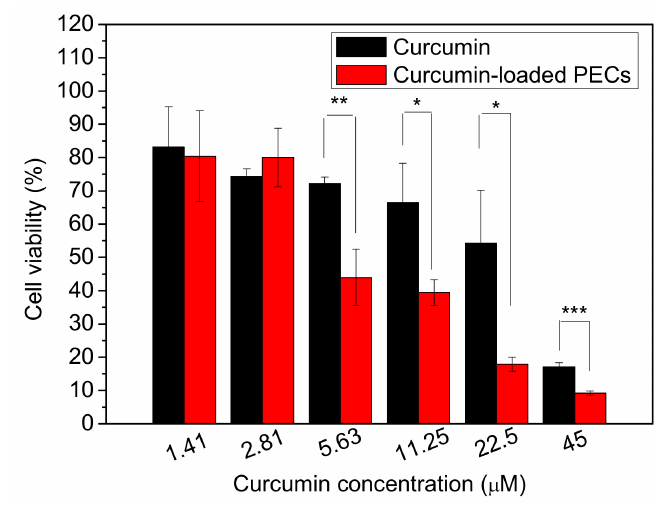
Figure 7. Cell viability. Curcumin and curcumin-loaded PECs were pretreated with pH 2.0 for 2 h and pH 8.0 for 4 h. Afterward, the pH values were adjusted back to 7.4. Next, HCT116 human colon cancer cells were incubated with the curcumin and curcumin-loaded PECs at 37 ◦ C with 5% CO 2 supply for 12 h. The curcumin and curcumin-loaded PECs were removed and the MTT assay was utilized to determine cell viability. The results have been statistically compared and analyzed using Student’s t -test (Microsoft Excel 2000). Differences were considered to be statistically significant when the p values were less than 0.05, and significant differences are shown in star marks (* p < 0.05; ** p < 0.01, and *** p <